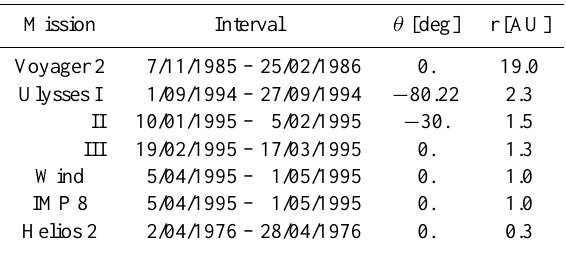
Table 1. Missions, times, heliographic latitude θ and distance r from the Sun of the 7 intervals Mission Interval θ [deg] r [AU] Voyager 2